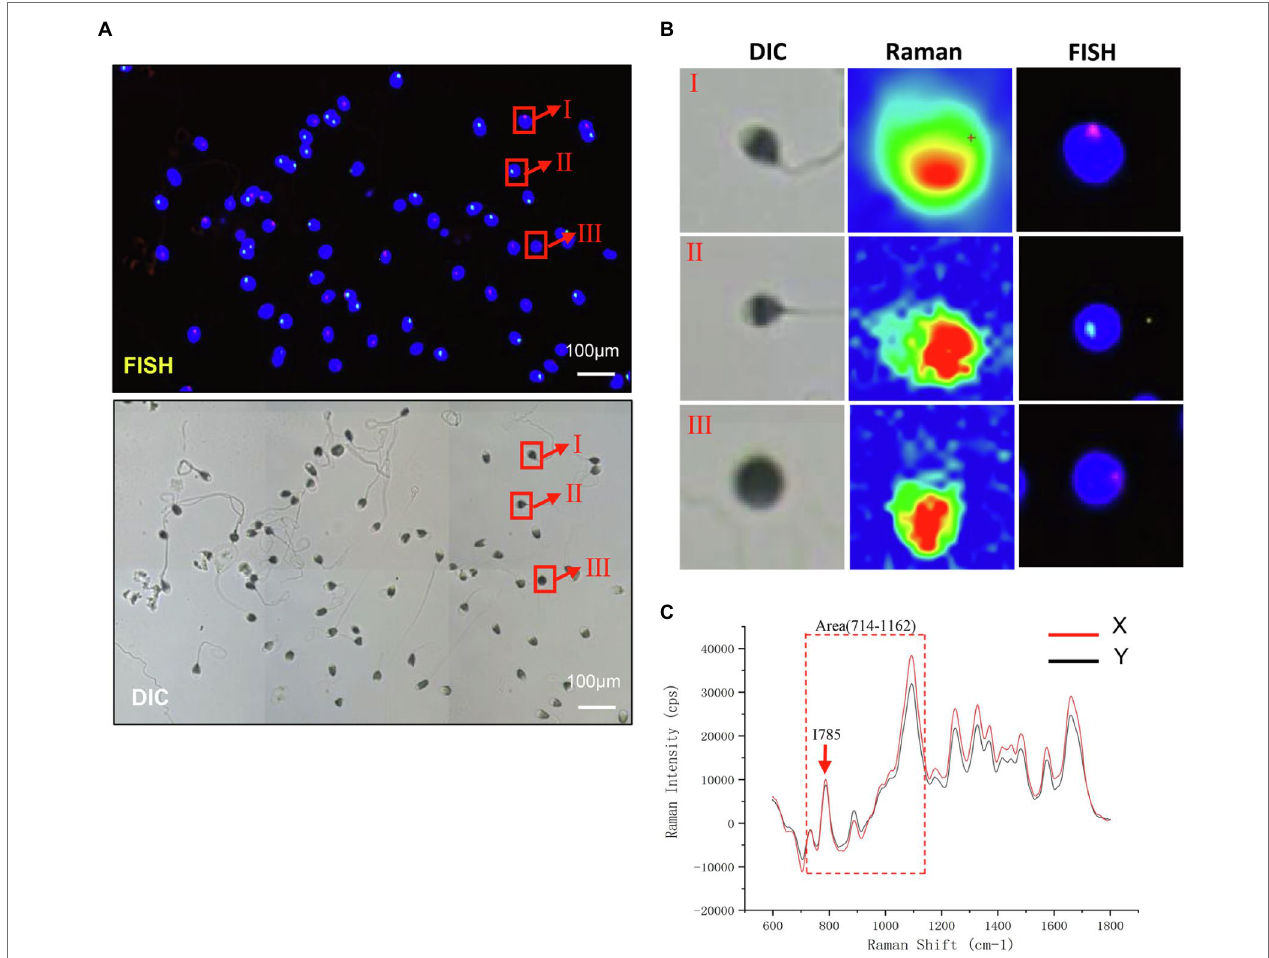
FIGURE 3 | Raman light micrograph and corresponding FISH result map. (A) Analysis of sperm sex chromosome status in FISH under a fluorescence microscope. The nucleus of sperm head is stained by DAPI. The red hybridization signal on the blue sperm head represents X sperm, and green represents Y sperm (scale bar,